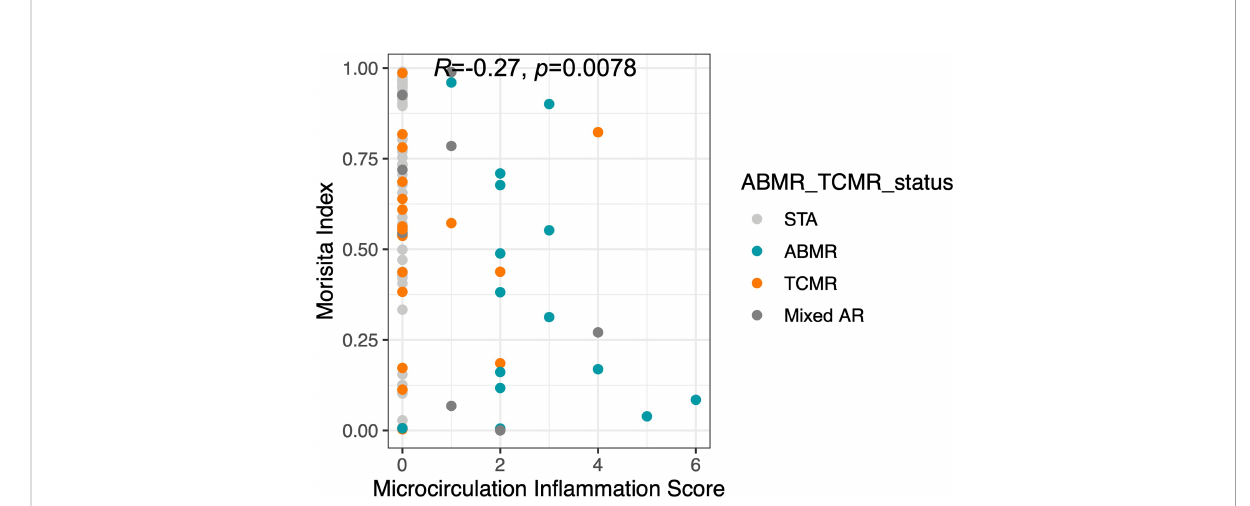
FIGURE 5 The Morisita Index inversely proportional to microcirculation in fl ammation. The fi nding of increased TCR turnover in terms of low Morisita Index among AR (ABMR, TCMR, Mixed AR) patients was further demonstrated by a signi fi cant